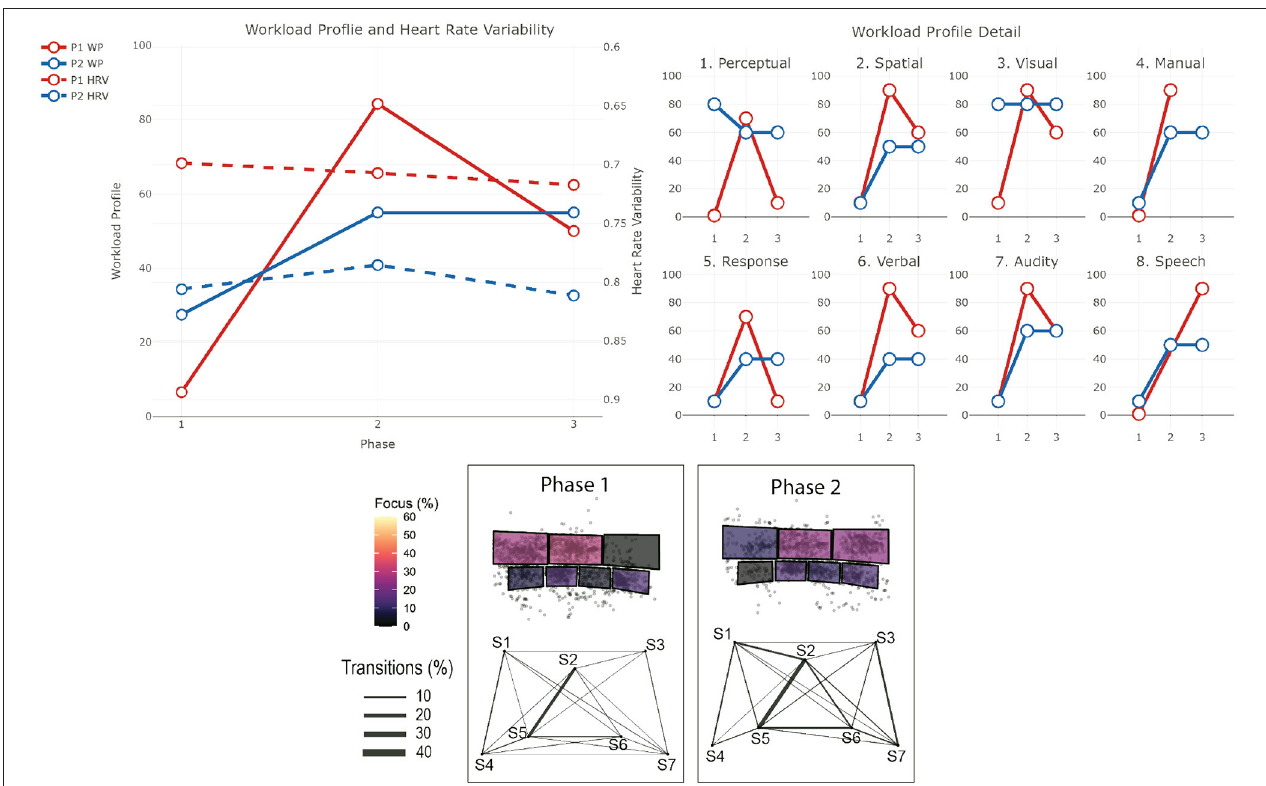
FIGURE 3 | Results for the first session of training 1. The top-left chart shows the evolution of the WP and HRV during the session for both participants (the axis of the HRV is inverted). The top-right chart shows the evolution of each criteria of the WP during the session for both participants. The bottom chart displays eye tracking data for P2 for each phase: at the top is the schematic representation of the operator’s workspace with a heatmap showing the amount of time the operator spent focusing on each screen; the bottom graph indicates the amount of transition between each of the screens with the thickness of the lines. The same organization is used in the following